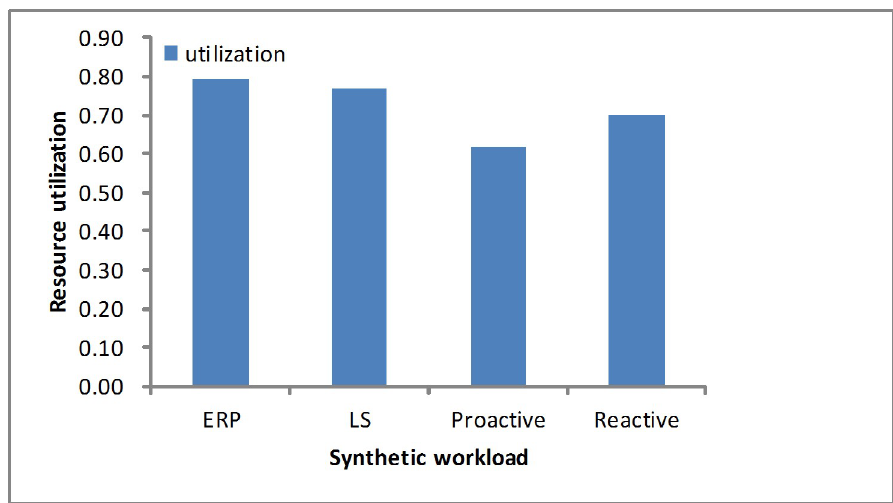
Fig 10. Average resource utilization in the synthetic